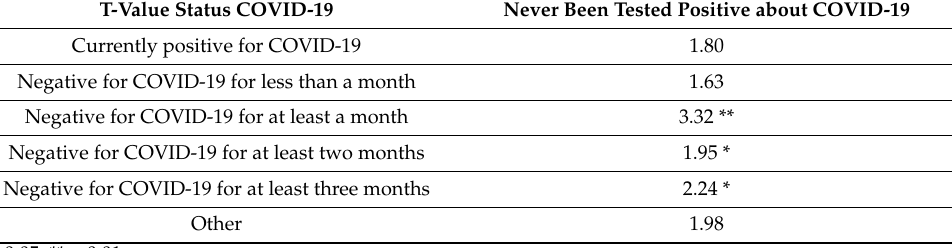
Table 4. T-Test analysis ( p < 0.05, FDR) of IRI Scores between “never been positive for COVID-19” and “currently positive for COVID-19 and negative for COVID-19 for less than a month”, “currently positive for COVID-19 and negative for COVID-19 for at least a month”, “currently positive for COVID-19 and negative for COVID-19 for at least two months”, “currently positive for COVID-19 and negative for COVID-19 for at least three months” and “other”. T-Value Status COVID-19 Never Been Tested Positive about COVID-19 Currently positive for COVID-19 1.80 Negative for COVID-19 for less than a month 1.63 Negative for COVID-19 for at least a month 3.32 ** Negative for COVID-19 for at least two months 1.95 * Negative for COVID-19 for at least three months 2.24 * Other